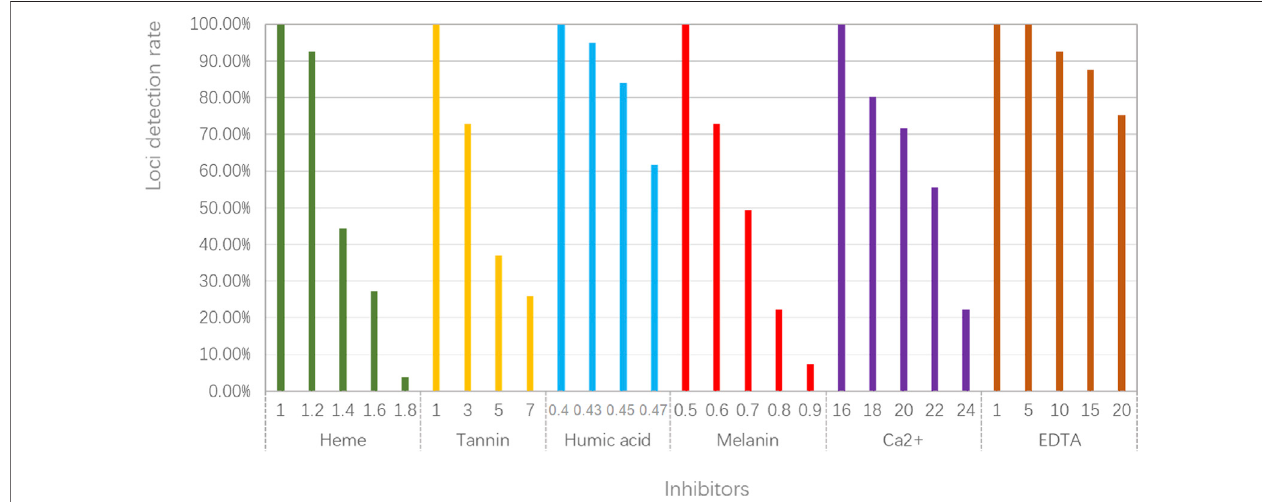
FIGURE 4 | Stability studies of the STRtyper-27 comp kit for six common inhibitors.